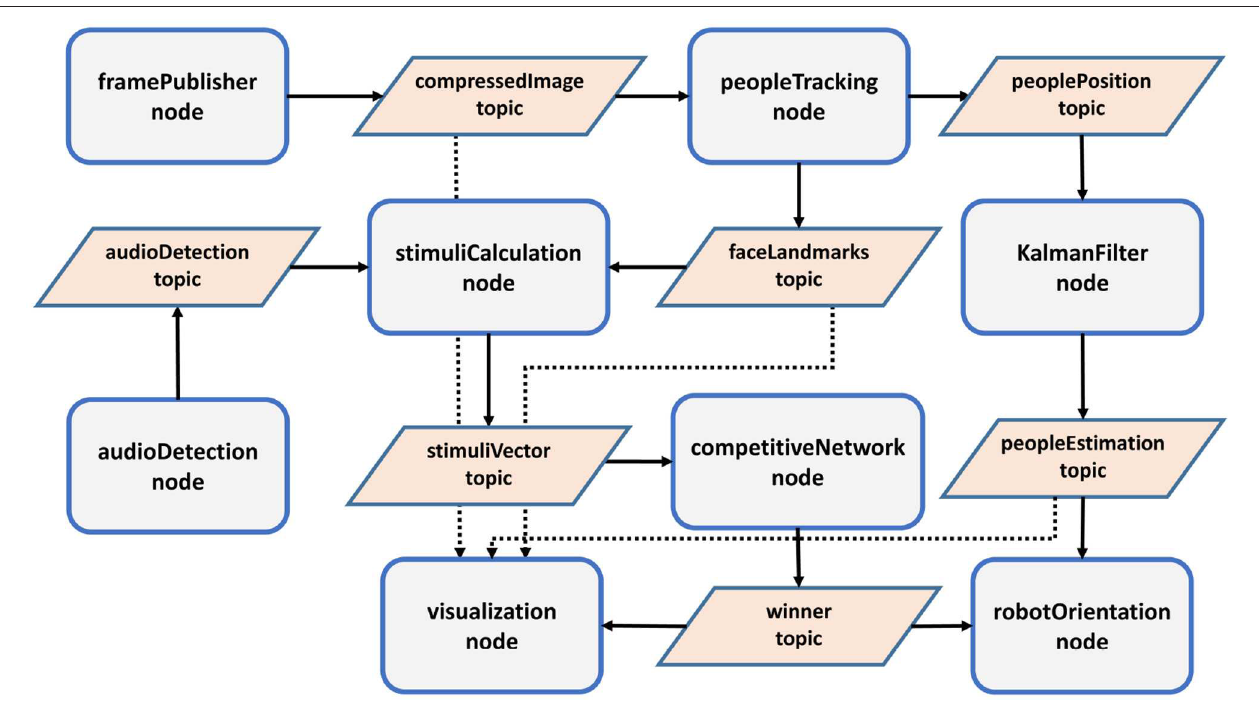
FIGURE 9 | ROS architecture.